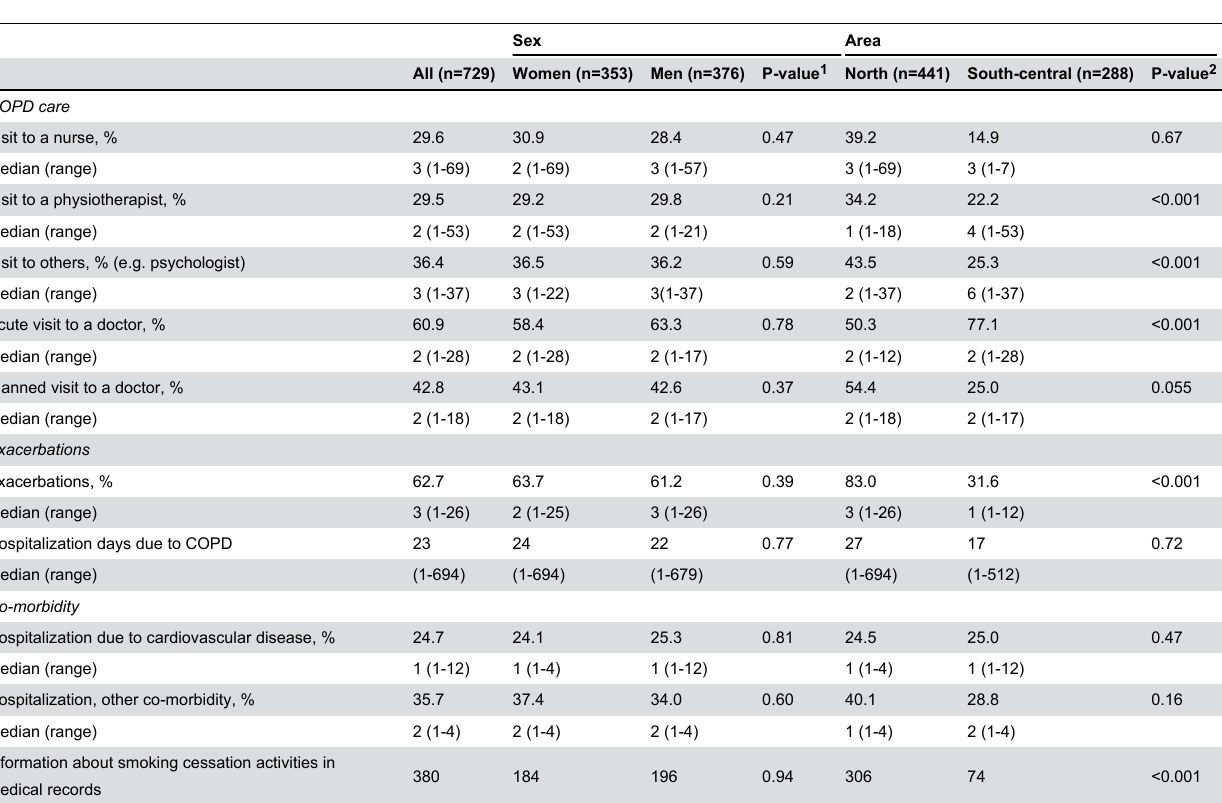
Table 4. Contacts with representatives of the COPD-team, exacerbations, co-morbidities and smoking cessation